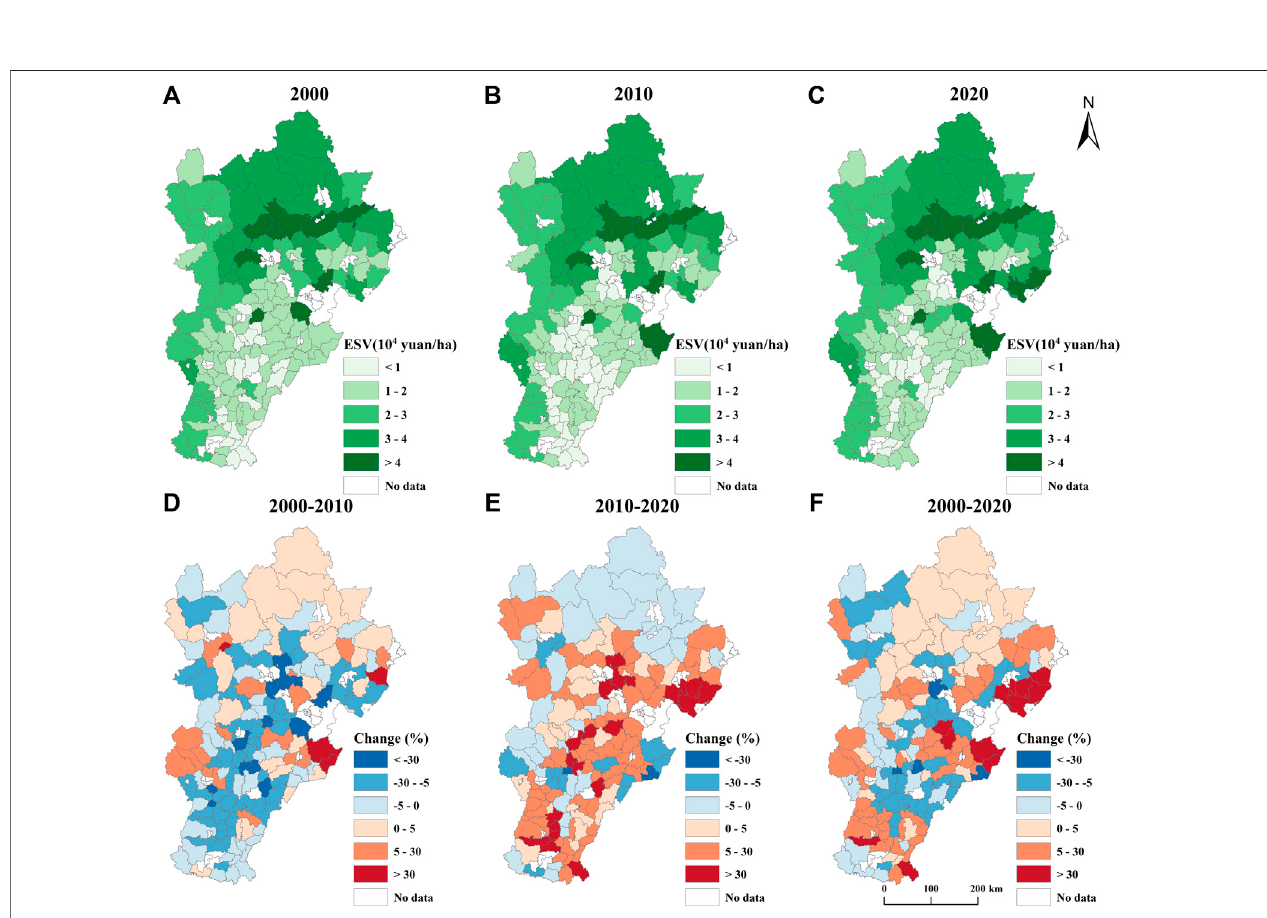
FIGURE 6 | Spatial-temporal changes in total ecosystem service values in the Beijing-Tianjin-Hebei